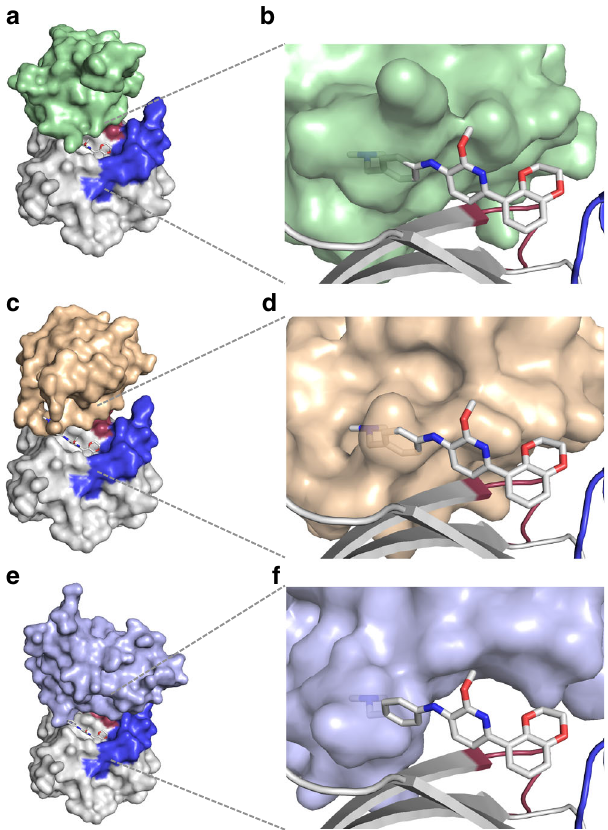
Fig. 6 Superimposed structures of KRAS 169 Q61H -Abd-7 and RAS-effectors (RAF, Pi3K and RALGDS). The potential interactions that could prevent Abd-7 and a RAS effector binding simultaneously to the same KRAS molecule have been modelled by overlaying the structure of the KRAS 169 Q61H -Abd-7 complex onto published structures. In each case, simultaneous binding of KRAS to Abd-7 and the effector is sterically forbidden. a , b Overlay with HRAS-CRAF RBD (PDB 4G3X). Abd-7 would overlap with residues 62-67 of CRAF. c , d Overlay with HRAS-RALGDS RBD (PDB 1LFD). Abd-7 would overlap with residues 29-31 of RALGDS. e , f Overlay with HRAS-PI3K γ RBD (PDB 1HE8). Abd-7 would overlap with residues 227-229 for